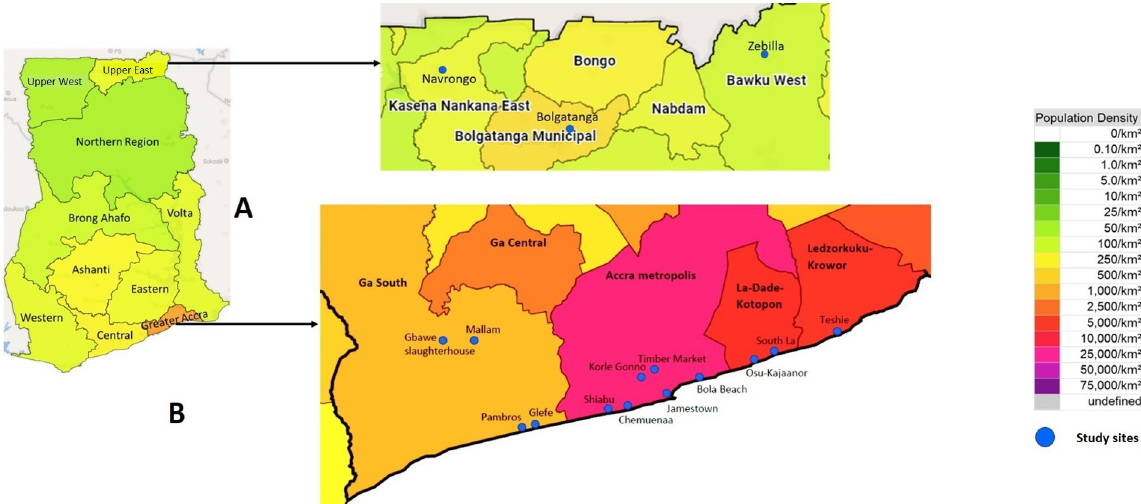
Fig 1. Study sites. (A) Upper East Region (B)Greater Accra